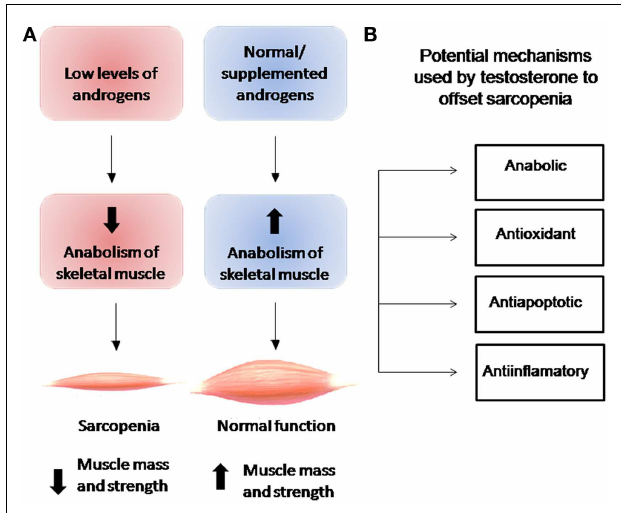
FIGURE 1 | (A) Relationship between levels of androgens and anabolism of skeletal muscle and their effects on muscle mass and strength. (B) Cellular effects of testosterone on skeletal